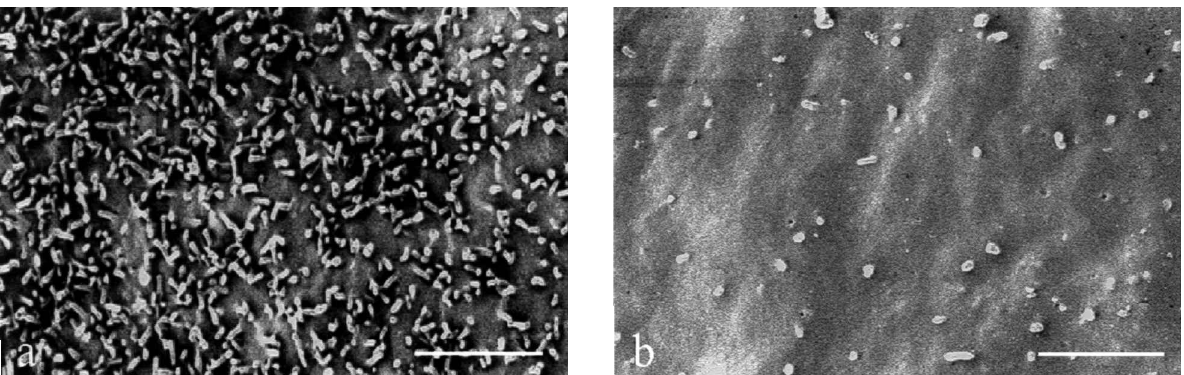
FIG. 5. Scanning electron micrographs of 16HBE14o– cells: (a) control, (b) exposed to poly- L -arginine. Note changes in cell processes. Bar = 2 m